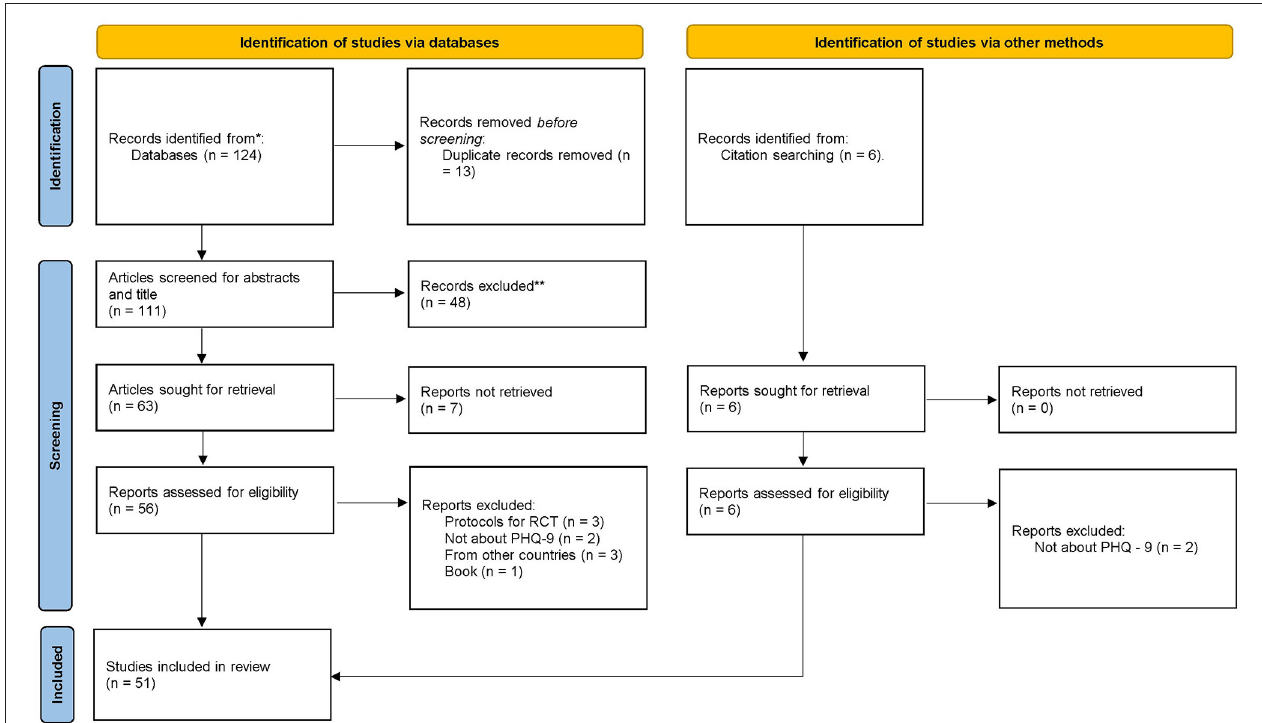
FIGURE 1 | PRISMA